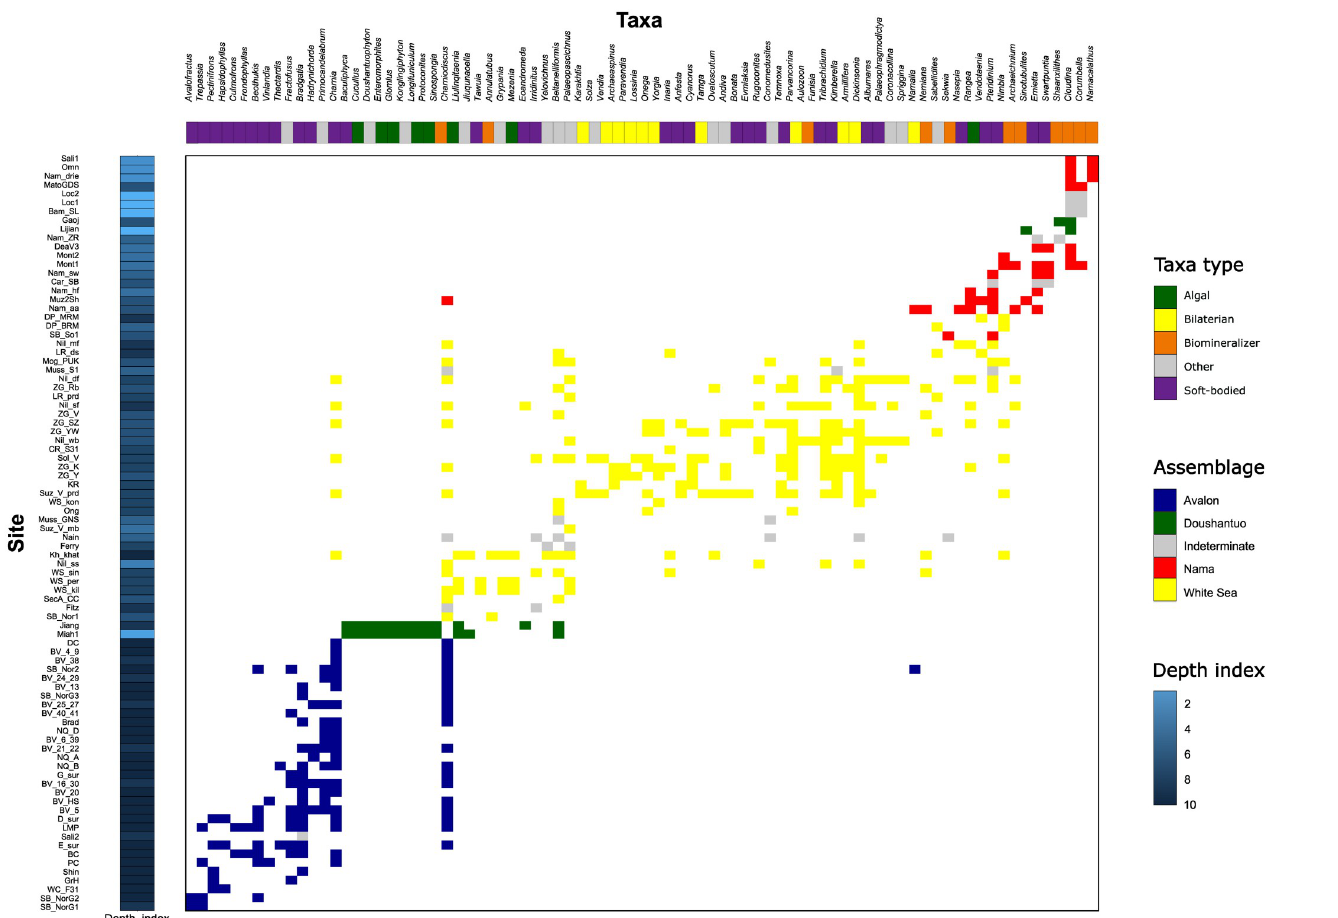
Fig 2. Ordinated data table. The assemblage and palaeoenvironment for each locality are given on the left. Sites are ranked based on reciprocal averaging ordination. Right plot shows the incidence matrix for taxa (columns) for all sites (rows) along the inferred environmental gradient after ordination. Ordination was calculated according to occurrence resulting from the overall metacommunity analysis. The presence of a taxon is given by a coloured square, absence by white. Doushantuo and indeterminate sites were excluded from the assemblage-level analyses. Depth index indicates the relative depth of the locality (cf., [8 AU : PleasenotethatBoagetal : 2016 hasbeenchangedtoreferenceno : 8 tolinkwiththeoneinthereferencelist : Pleaseconfirmthatthischangeiscorrect : ]), as determined by palaeoenvironment. The data underlying this Figure can be found in 10.6084/m9.figshare.13664105&quot;https://doi.org/10.5061/dryad.1mh30 and in S1 Data.